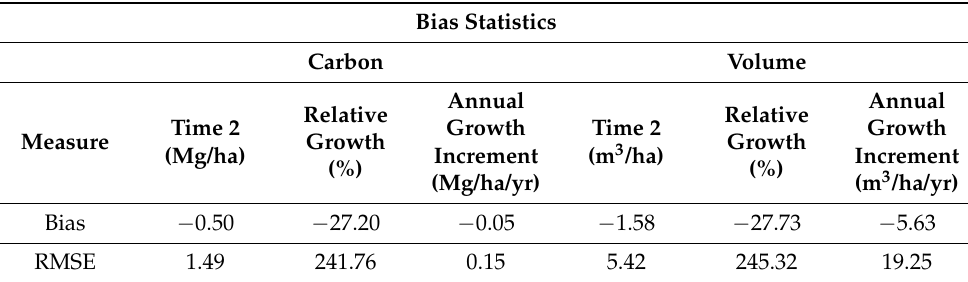
Table 2. Bias and RMSE results for stand-level above-ground, non-foliar, tree carbon (wood and bark) and bole wood volume, comparing Time 2 (stocks predicted ~10 years forward), Relative Growth (relative growth as a percent of initial stocks), and Annual Growth Increment.